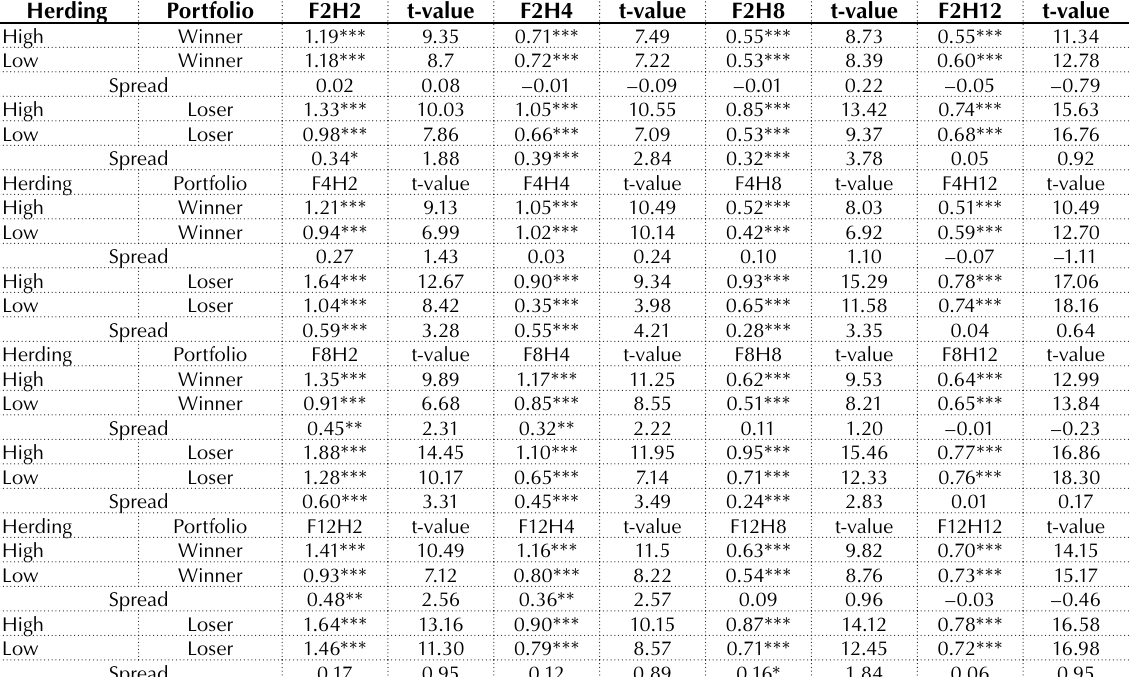
Table 3. Effect of degree of herding on return of investment portfolio